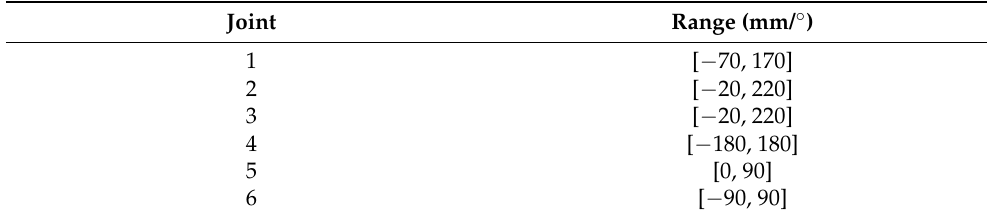
Table 1. Definition of the robot joint space.